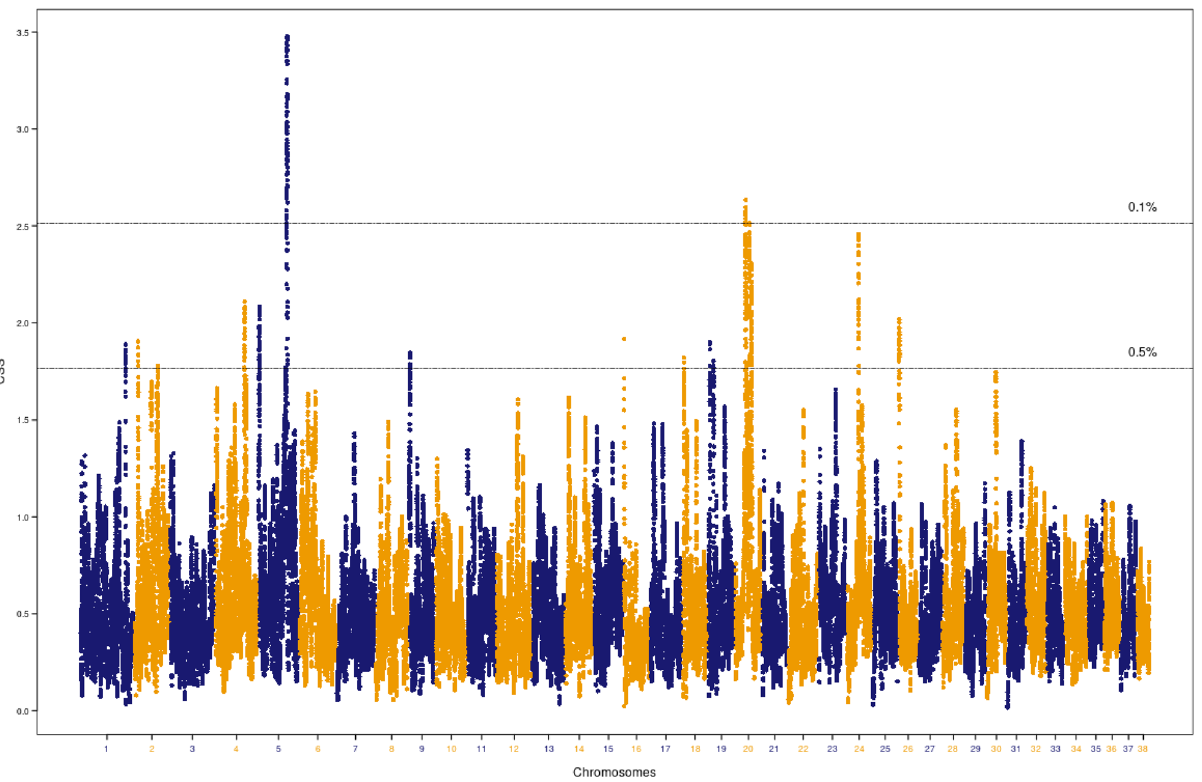
Figure 5. Composite selection signals associated with hunting ability. CSS statistics were determined with Mountain hounds as the target group. The canine chromosomal positions of SNP markers are plotted on the x-axis. The observed values for selection scan statistics based on the combination of F st , ∆DAF and XP-EHH are highlighted in blue and orange. Each point represents the smooth CSS value in a 1 Mb overlapping sliding window across the autosomes. The two-dashed horizontal lines indicate threshold values for the top 0.1% (top) or 0.5% (bottom) of CSS values.